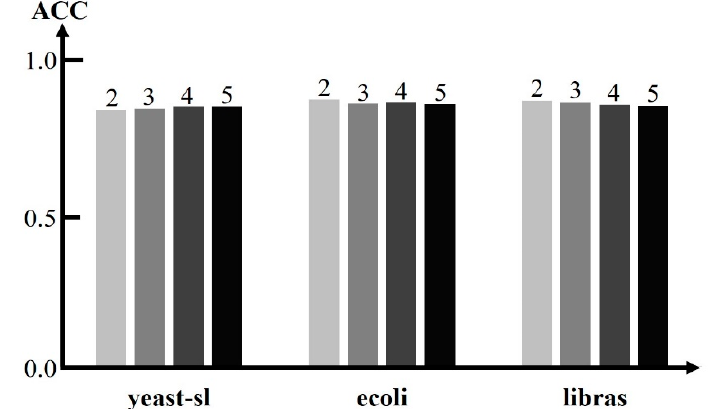
Figure 9. Performance of SL-Scheme with variation in the number of input dimensions selected by MI.